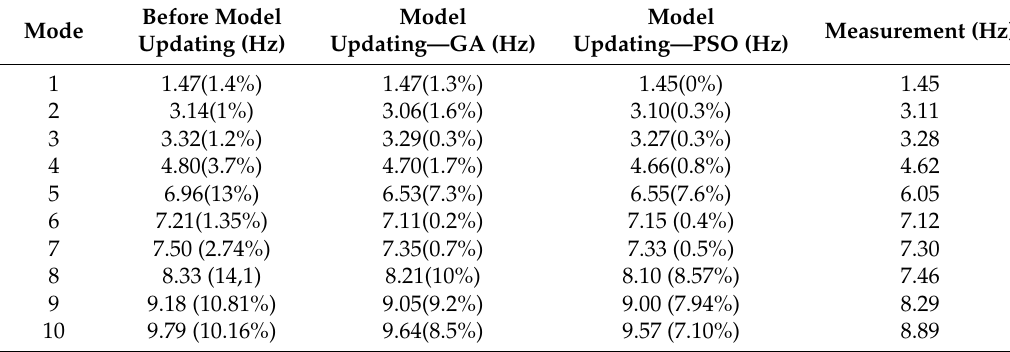
Table 5. The modal frequencies from the FE model after model updating compared to the measurement.